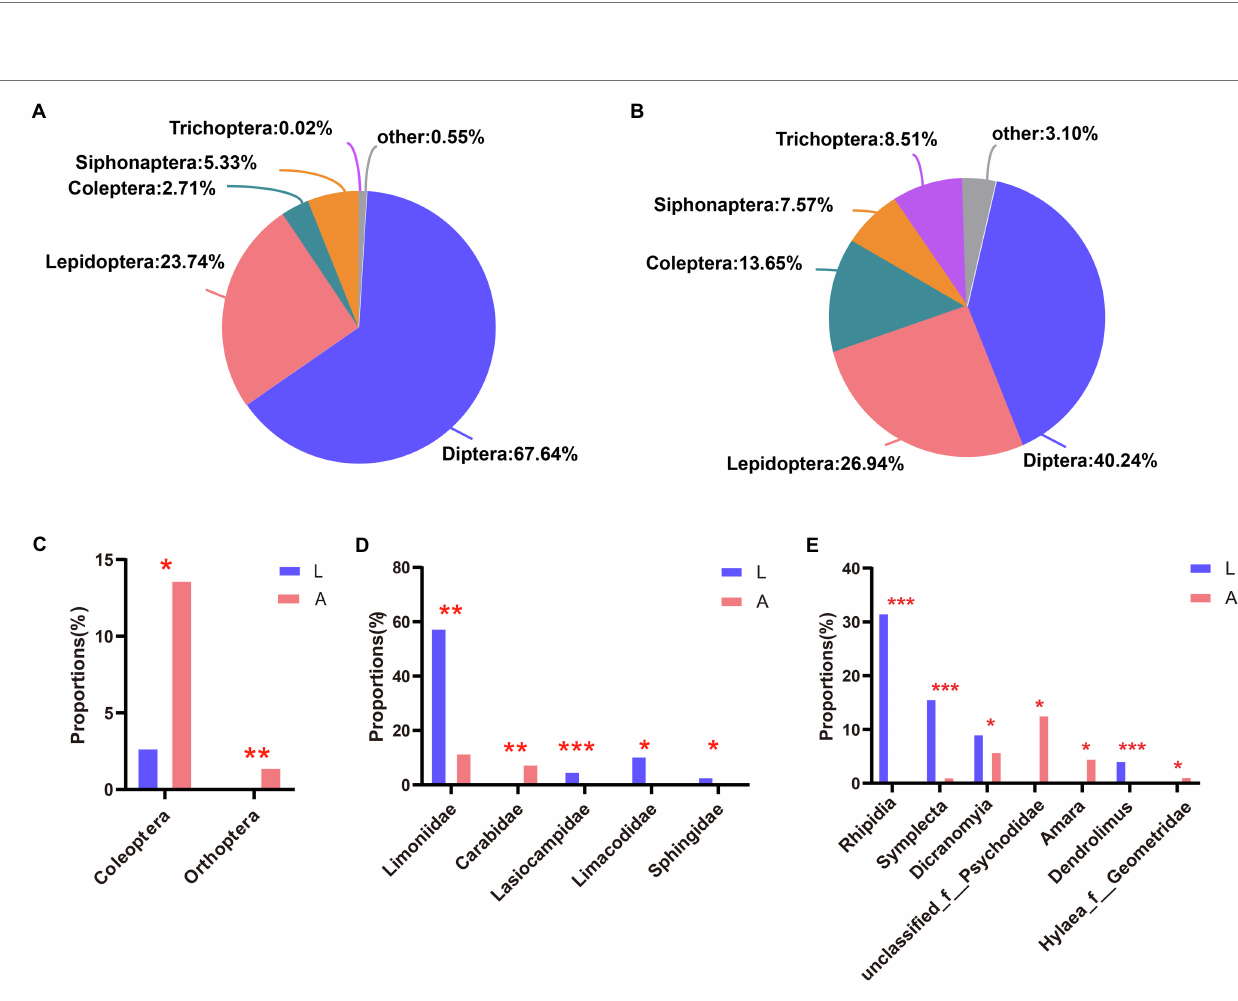
FIGURE 3 | (A,B) Composition at the order level of insect species in the diet: (A) Lactating bats and (B) Non-lactating bats. (C–E) Analysis of insect species composition differences: (C) Analysis of order-level differences, (D) Analysis of family-level differences, and (E) Analysis of genus-level differences (*0.01 < p ≤ 0.05, **0.001 < p ≤ 0.01, and *** p ≤